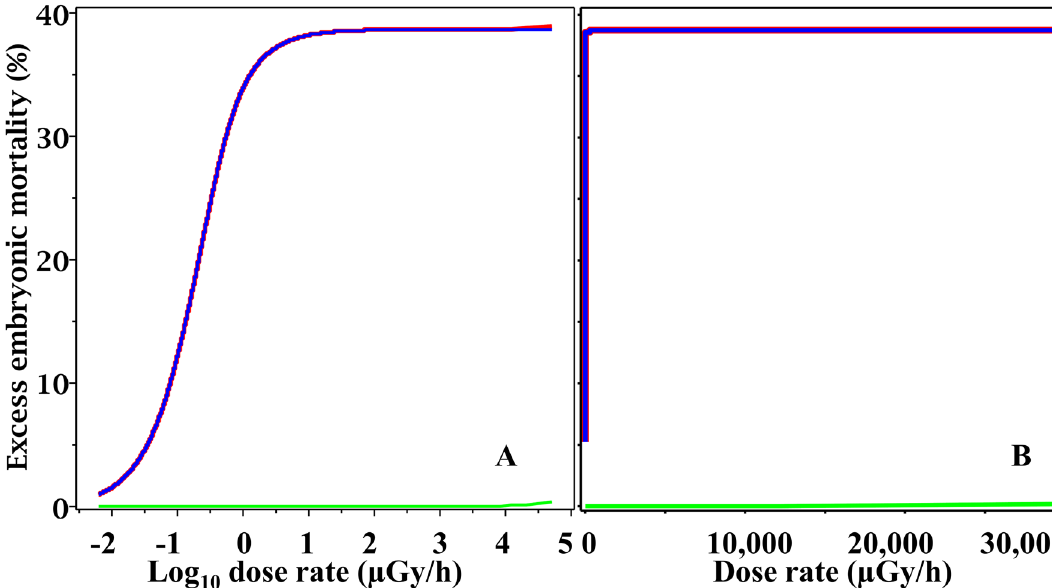
Figure 5. Predicted radiation responses at different constant dose rates based on best-fit model parameters for rodent ( Clethrionomys glareolus ) data. ( A ) Dose rate shown on logarithmic scale for better visualization of low dose rates. ( B ) Dose rate shown on linear scale. Red curve = total radiation response (TE and NTE). Blue curve = NTE only. Green curve = TE only. Time since the start of exposure to the constant dose rate was set to 20 years so that near-equilibrium for the response could be achieved.